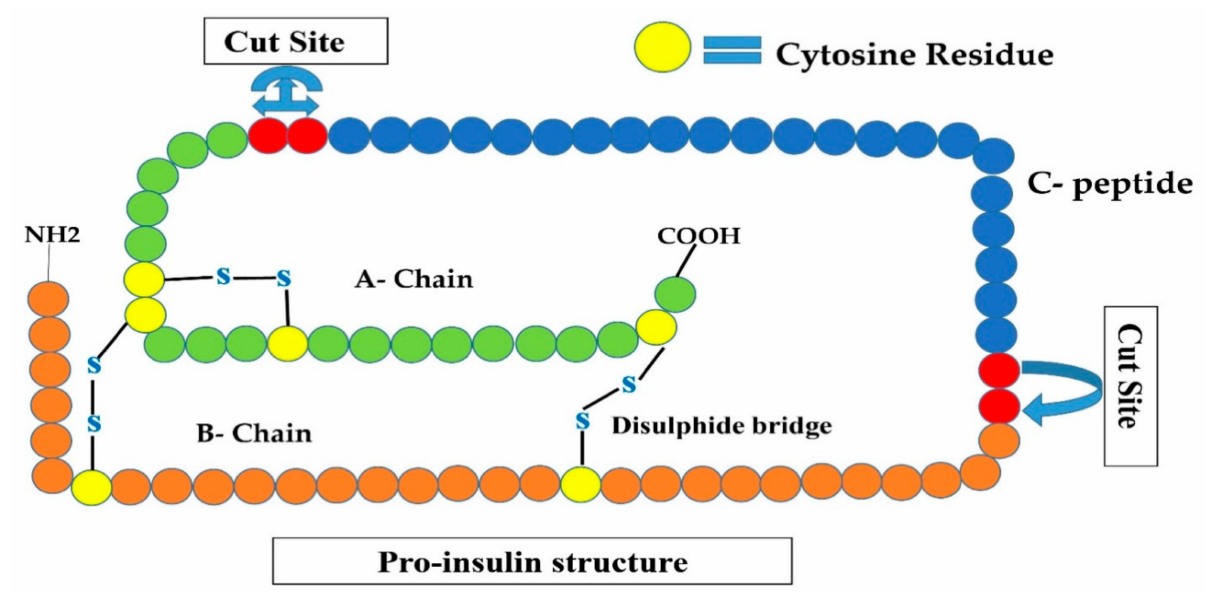
Figure 2. Shows the proinsulin structure that is an inactive form of insulin (A-chain, B-chain, and C-peptide). Convertases I and II remove C-peptide by cleavage at two sites are shown by red circles, converting this inactive insulin to active human